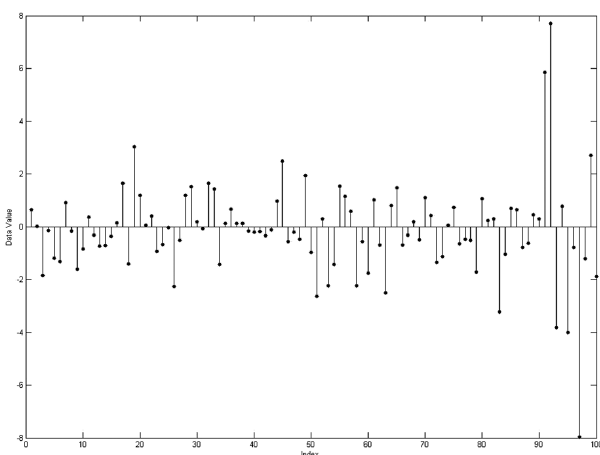
Figure 4: Spread observation example of a group of data as example of generalized ESD data.